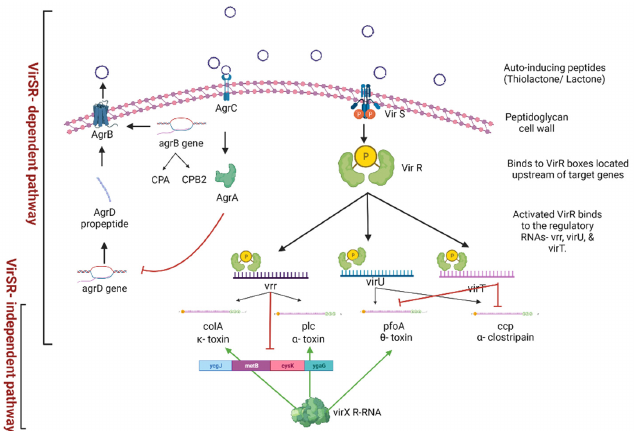
Figure 1. Regulation of virulence gene activation and toxin production by the quorum sensing dependent VirS–VirR regulatory system in C. perfringens . Created with Biorender.com (accessed on 30 May 2022).